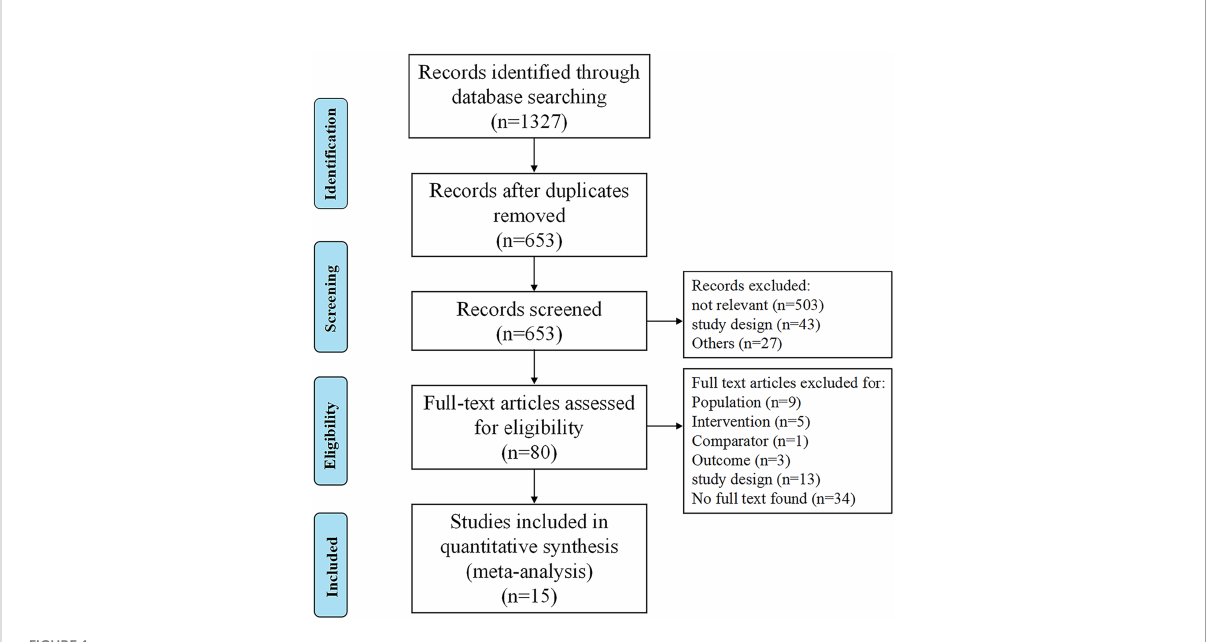
FIGURE 1 PRISMA fl ow diagram of the selection and inclusion